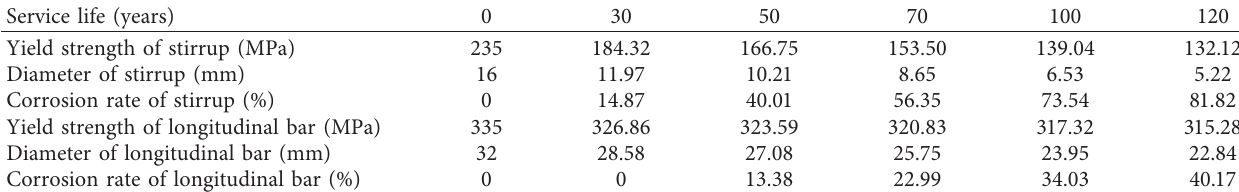
Table 3: The characteristic values of steel bars corresponding to different service periods.